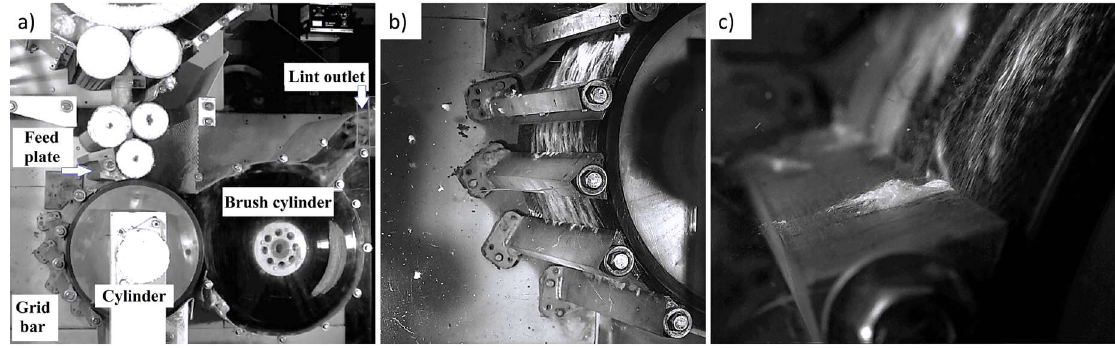
Figure 1. ( a ) Different components of lint cleaner machine; ( b ) set of grid bars inside lint cleaner; ( c ) interactions between fiber and grid bar.